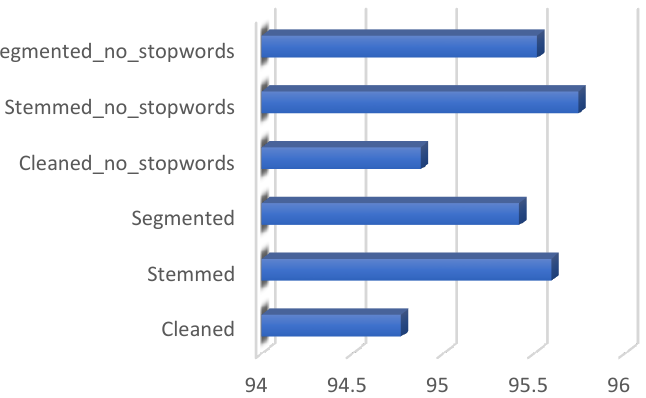
Figure 4. Performance evaluation of SVM with different TF-IDF analyzers.